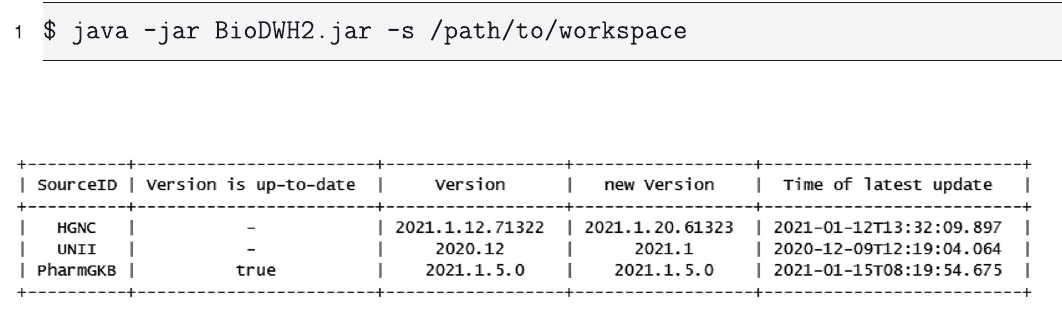
Figure 3: Example output of the BioDWH2 status